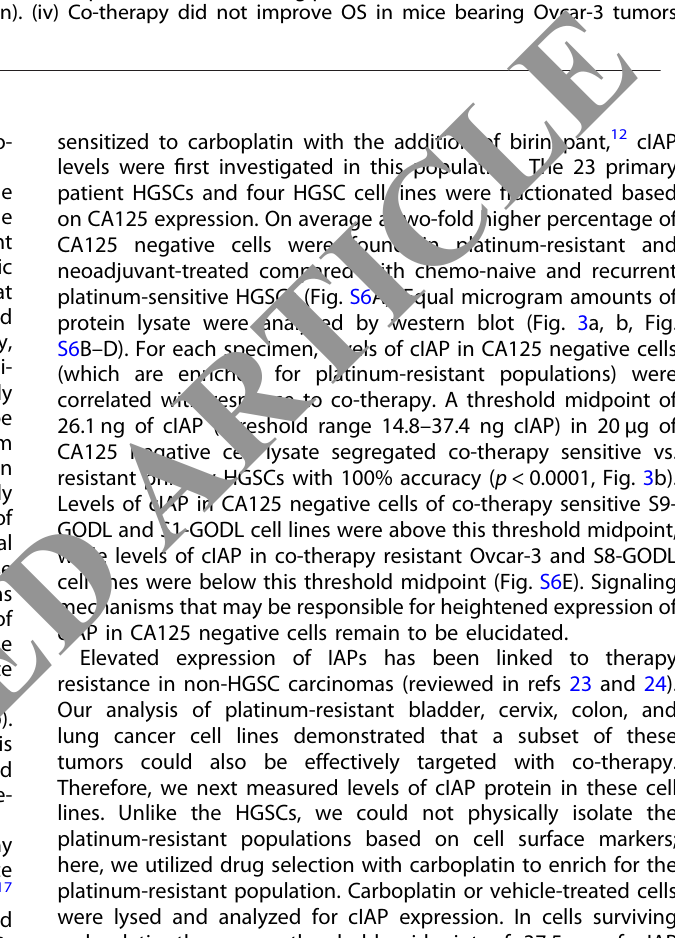
Fig. 1 OS of mice bearing bioassay positive platinum-resistant or sensitive human HGSCs improved with birinapant and carboplatin co- administration. a Schema of in vitro organoid bioassay. Organoids treated with drug for 72 h were released, dissociated, and analyzed